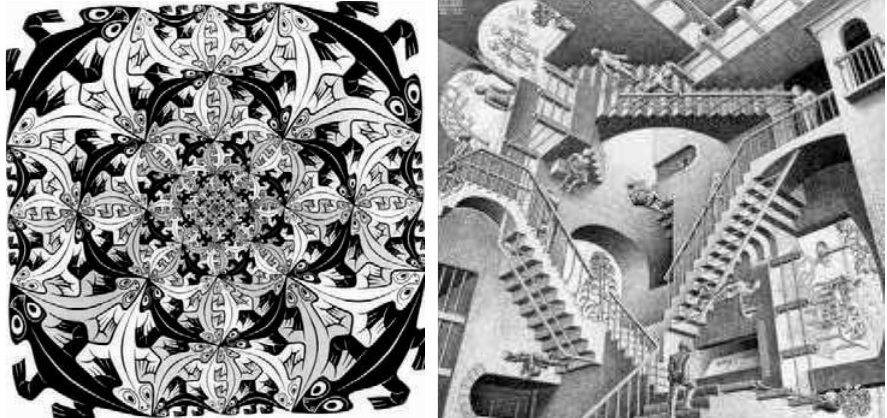
Figure 3. Ascending and Descending (M. C. Escher) Source: http://www.utwente.nl/ewi/trese/.